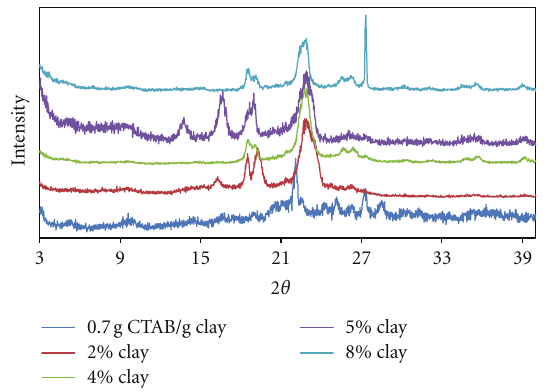
Figure 6: XRD patterns for produced PEO/clay nanocomposites at various clay compositions (1.5 g CTAB/g clay